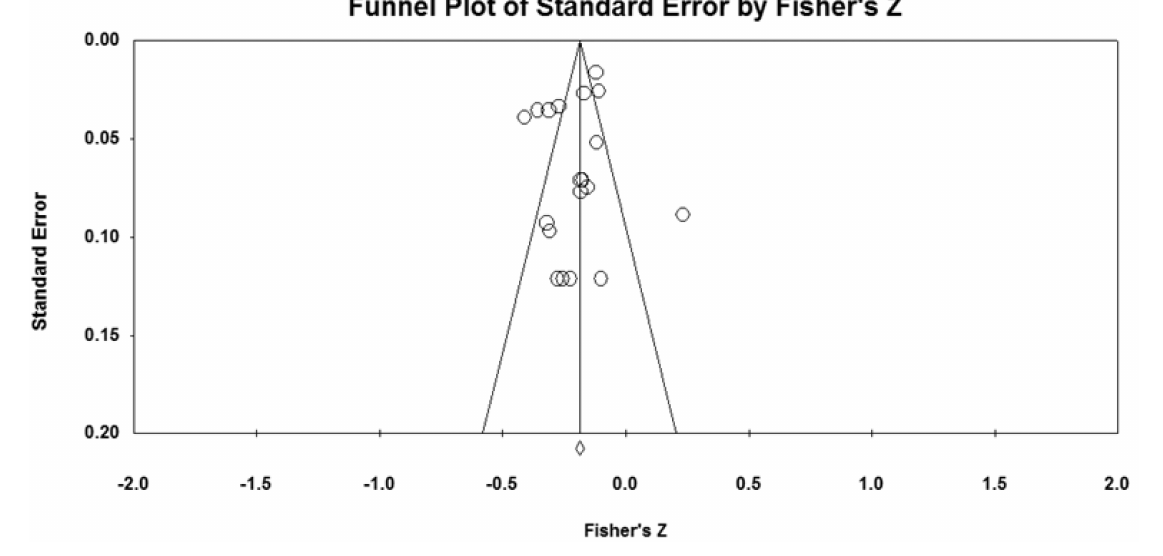
extracted from the included articles. Because of the high heterogeneity in this study, random-effect models were used to calculate all of the combined effect sizes. The combined effects of authoritative, authoritarian, indulgent, neglecting, and inconsistent parenting styles on sibling conflicts were calculated, respectively. Subgroup analyses using gender, mean age, region, outcome measure, and publication year as moderators explained the majority of the heterogeneity. Finally, the funnel plot, fail- safe ratio N test, and Egger’s linear regression were used to test the publication bias of this meta-analysis. The findings revealed that there was no publication bias, and the findings were stable and